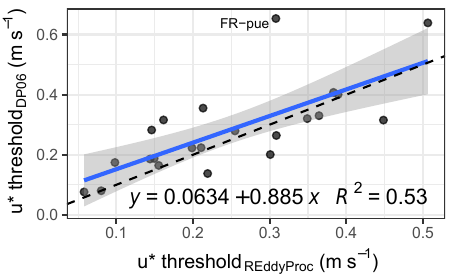
Figure 3. u ∗ thresholds derived using different methods deviate for single sites. The relationship across site years is retained as indi- cated by a regression (solid line with shaded uncertainty bound) close to the 1:1 line (dashed).